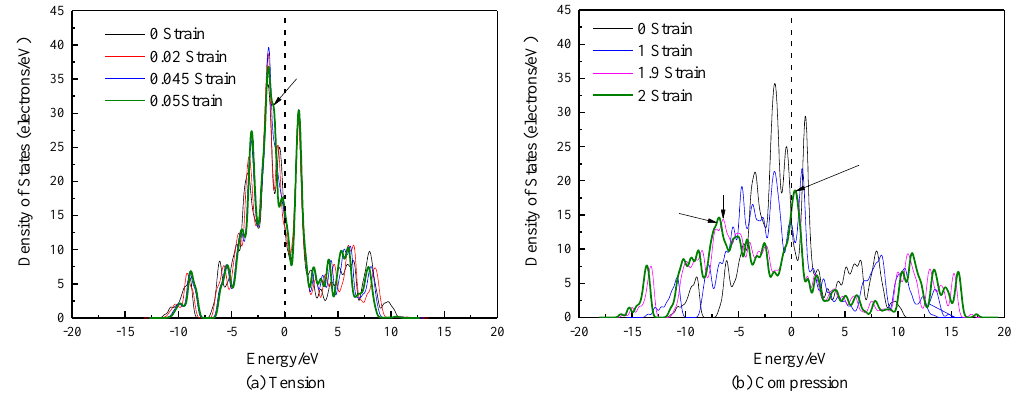
Figure 8. The change in band structure in the process of DO3 placed under triaxial compressive strain. ( a ) unstrained, ( b ) 0.1 strain, ( c ) 0.19 strain and ( d ) 0.2 strain. Figure 9. The change in electronic density of state in the process of tension and compression. ( a ) tension, and ( b ) compression.